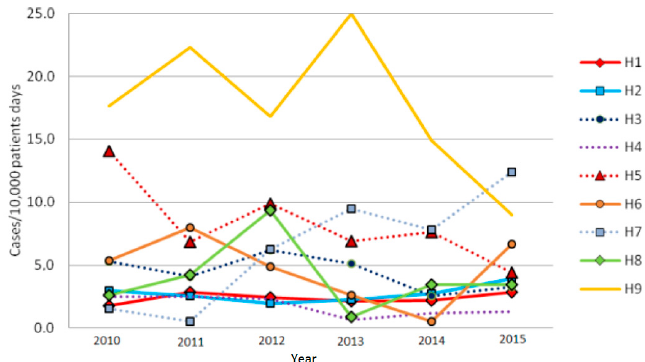
Figure 2. Trends of CDI incidences per year in the nine hospitals of the Local Health Authority of Bologna. Table 3. Overall incidence of CDI stratified per wards,